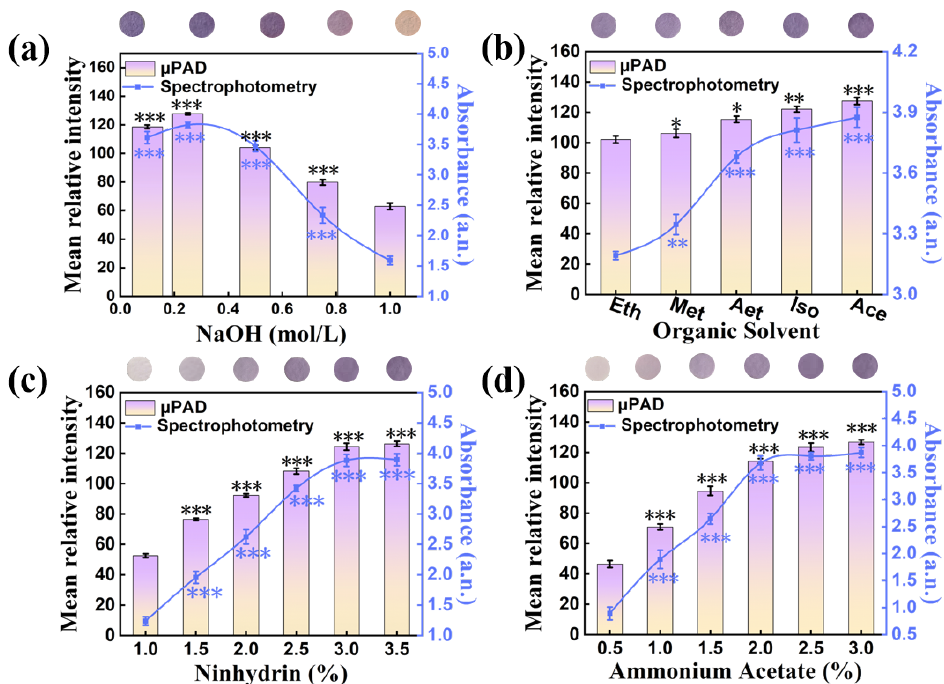
Figure 10. The factors affecting the experimental results on pSBMA-μPAD and spectrophotometry: ( a ) the concentration of hydrolytic solution, ( b ) the hydrolytic solution system, ( c ) the concentration of ninhydrin and ( d ) the concentration of ammonium acetate. “*” stands for significance test.